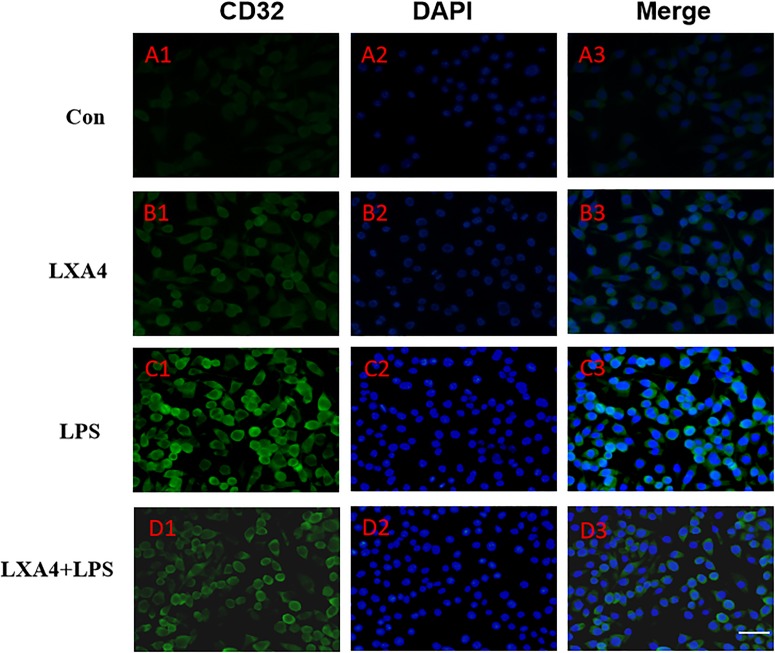
Immunofluorescence images showing the BV2 microglia after LPS stimulates which were labeled with CD32 antibody, with LXA4, the expression of iNOS is decreased. Green fluorescence indicated CD32 positive cells, while blue fluorescence indicated DAPI-labeled nuclei. Scale bar: 20 μm.